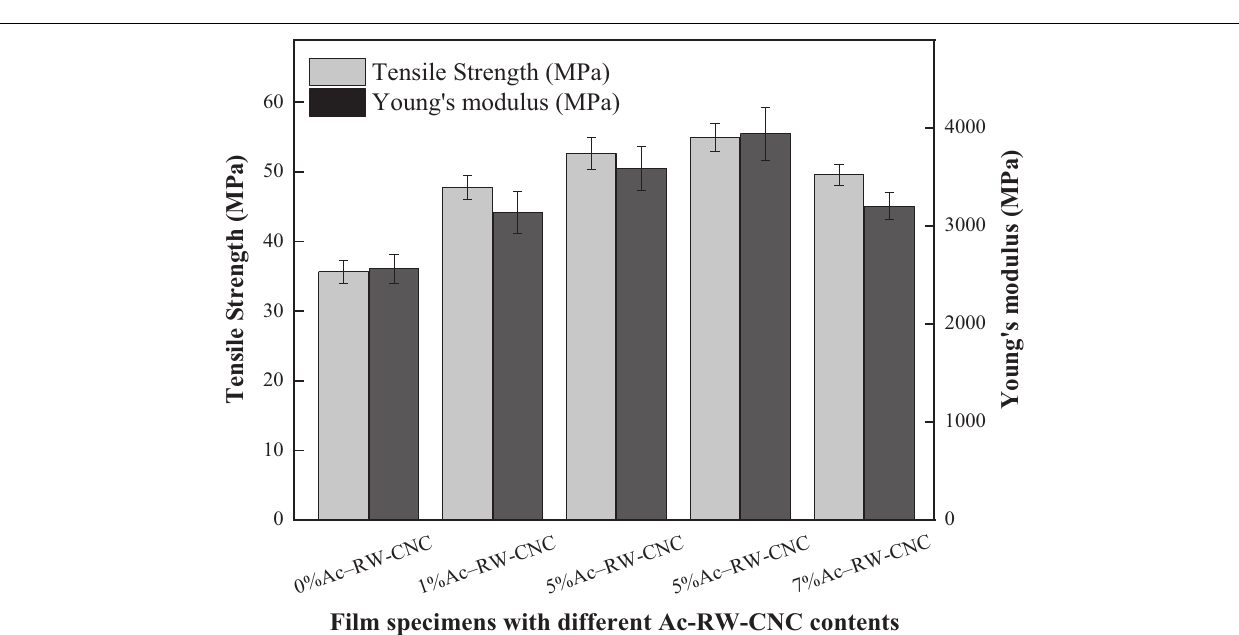
FIGURE 7 | Tensile strength and Young’s modulus of Ac–RW–CNC/PLA composite